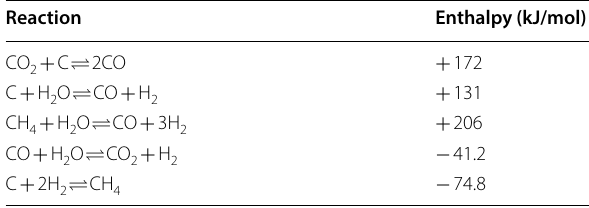
Table 5 Properties and gas composition from spent coffee grounds through TCR ® system and other technologies